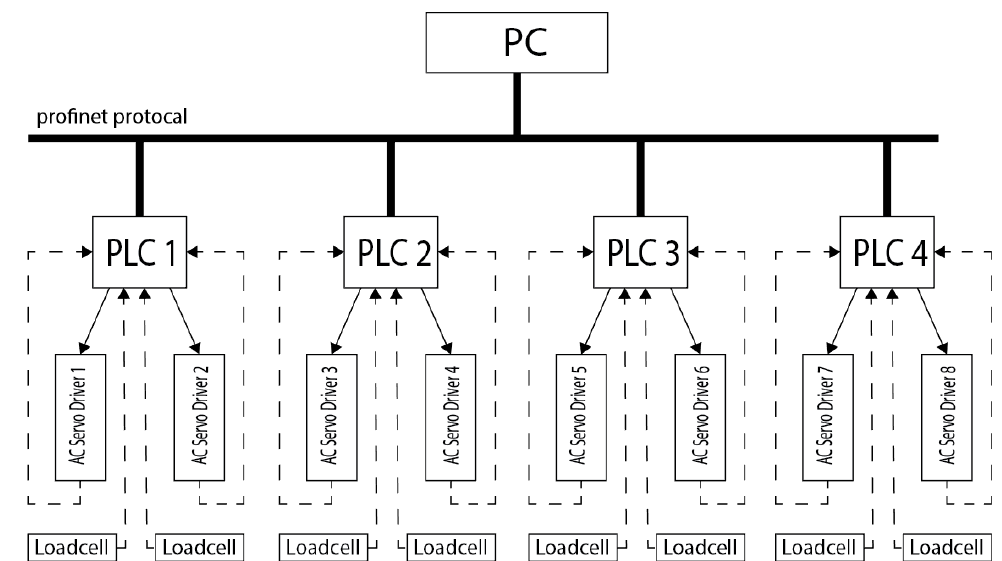
Figure 14. Structure of the CDPR’s controller.